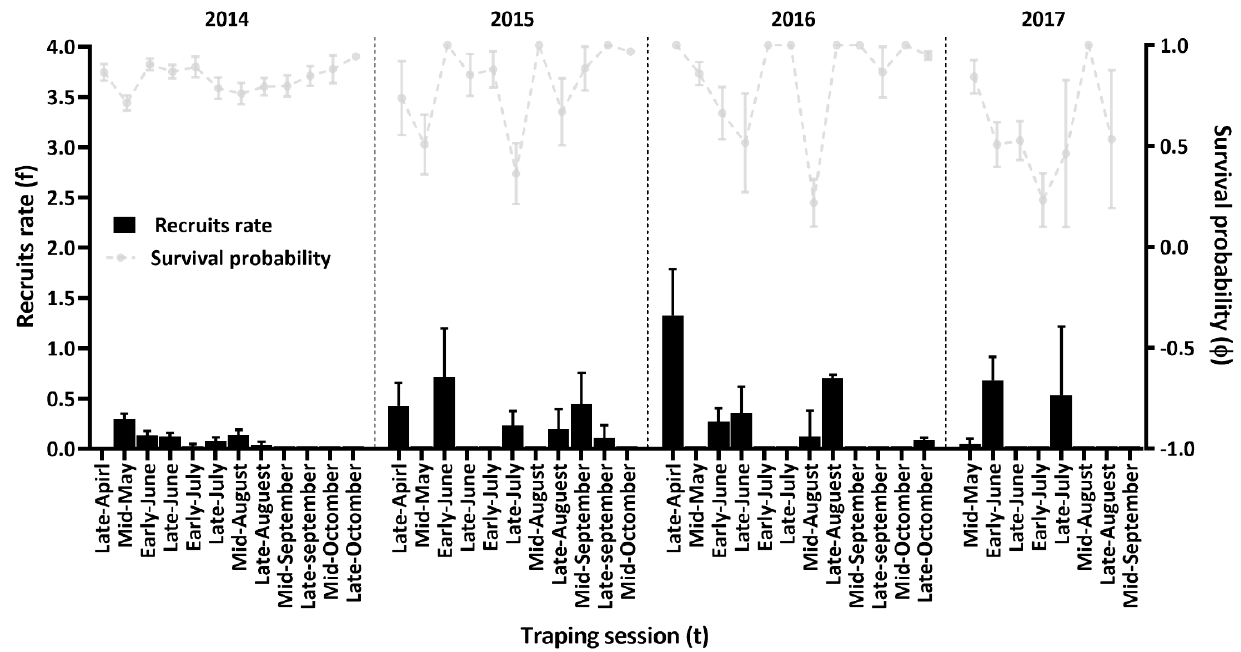
Figure 3. Estimates of half-monthly survival probabilities and recruitment rates of Mongolian gerbils ( Merionus unguiculatus ) in Houhatai, Inner Mongolia, China, from April 2014 to September 2017. The estimates were generated using the full time-dependent survival and recruitment model [ φ ( t )p(t)f(t)]. Vertical bars are standard error (SE). Time-dependent and sex-independent recapture probabilities were used in the envi- ronmental-covariate CJS models (Table 1). The most parsimonious of these models had survival probabilities ( φ ) as a function of population density (i.e., MNA/ha; coefficient = 0.013, 95% confidence interval (CI) = 0.007 to 0.019), precipitation (coefficient = 0.038, 95% CI = − 0.107 to 0.182), and the linear (coefficient = 0.113, 95% CI = 0.068 to 1.583) and quad- ratic (coefficient = − 0.002, 95% CI = − 0.0045 to − 0.0001) terms of temperature (Akaike weight = 0.983). The second-best model had a Δ AICc of 8.96 (Table 1, step1). Therefore, four combinations of covariates were used for the survival submodel and the recruitment rate submodel of the Pradel- f JS models (Table 1, step2): (1) temperature and population density, (2) temperature and precipitation, (3) temperature, precipitation and population density, and (4) a quadratic temperature term as the only covariates, the nonlinear effects of temperature. Table 1. Complex effects of temperature (°C), precipitation (mm) and population density on survival ( φ ) using the Cormack–Jolly–Seber (CJS) models or survival ( φ ) and recruitment rate ( f ) using the Jolly–Seber models for Mongolian gerbils ( Merionus unguiculatus ) in Houhatai, Inner Mongolia, China, from April 2014 to September 2017. AICc Model Model AICc Δ AICc Par Deviance Weight(w) Likelihood Step 1: Modelling survival probability, including environmental covariates with half-monthly temporal ( t )-dependent and sex-independent for recapture probabilities by the CJS models. φ (quadratic_temp + Pre + MNA/ha) p( t )